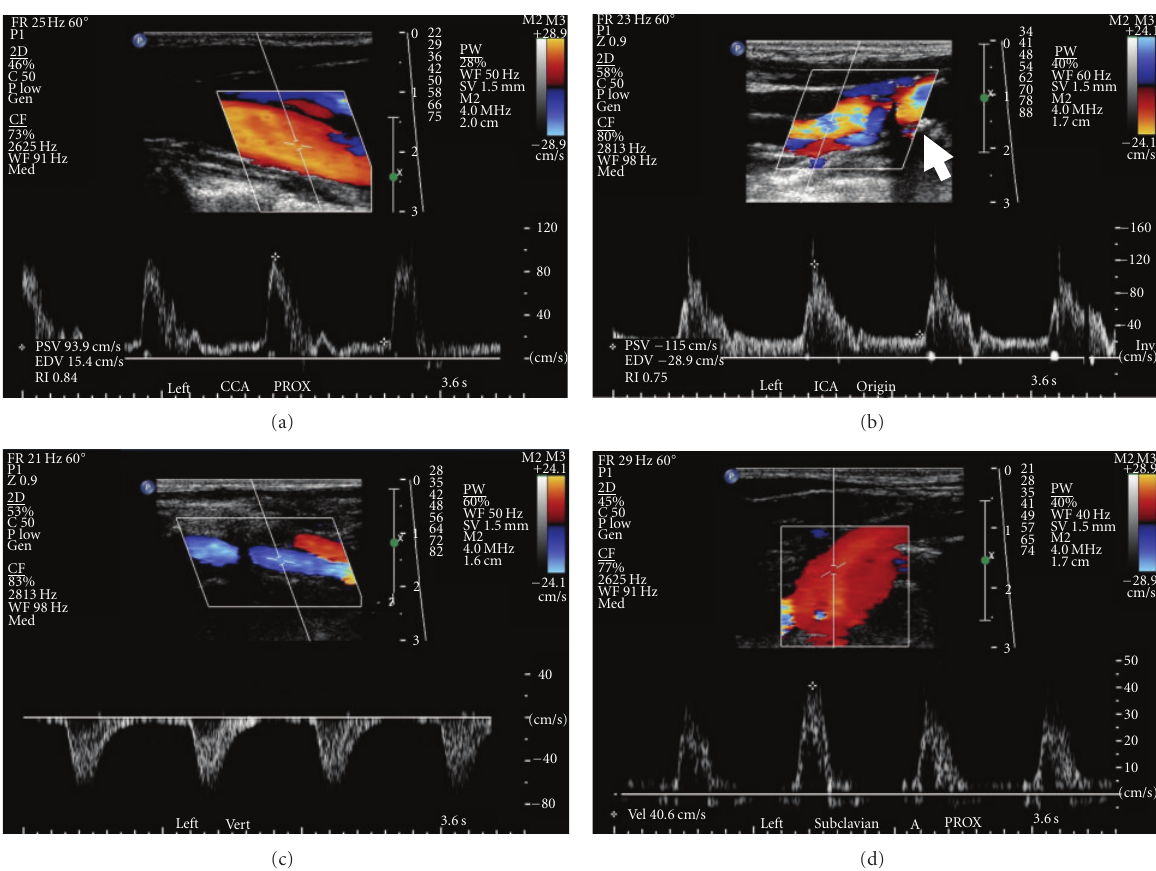
Figure 3: Color and pulsed-wave Doppler showing flow in left carotid, vertebral, and subclavian arteries: (a) showing proximal left common carotid artery. There is a relatively normal-appearing Doppler waveform, (b) note mild elevation in peak systolic velocity with plaque at left internal carotid artery origin (arrow). The stenosis is categorized as 40–59% in our laboratory. (c) Showing complete reversal of blood flow in left vertebral artery consistent with complete subclavian steal. (d) Low velocity blood flow with abnormal-appearing Doppler in left subclavian artery consistent with more severe subclavian stenosis proximal to this